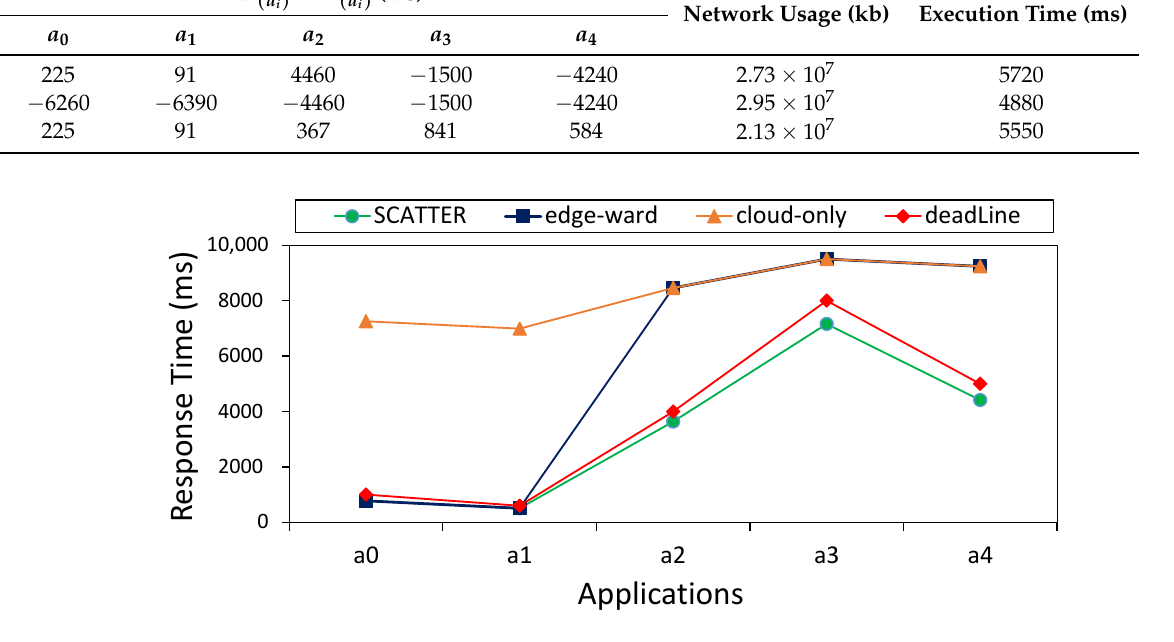
Figure 5. Response times of